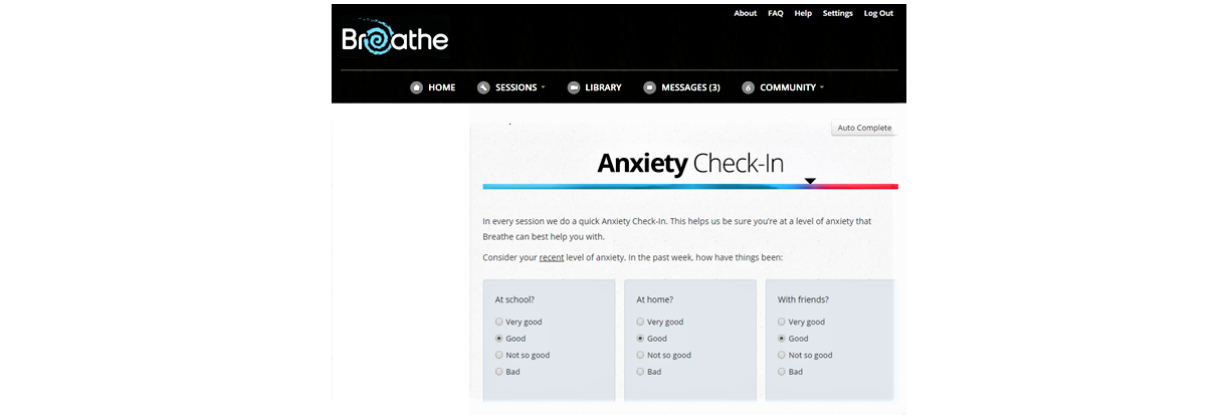
Figure 1. A screenshot of the Check-in activity within the Breathe program.